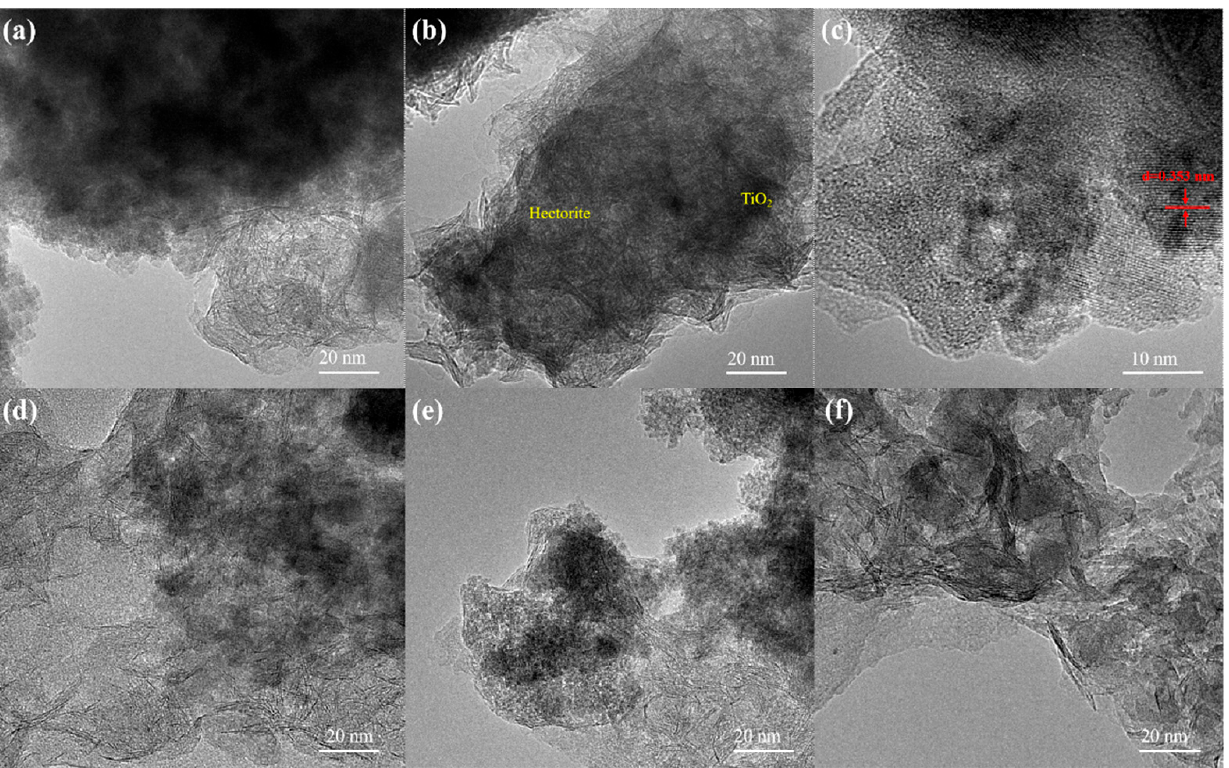
Figure 4. Transmission electron microscopy (TEM) images: ( a ) TH-1, ( b , c ) TH-2, ( d ) TH-3, ( e ) TH-4, and ( f ) TH-5.2.1.5. N 2 adsorption-desorption isotherms.